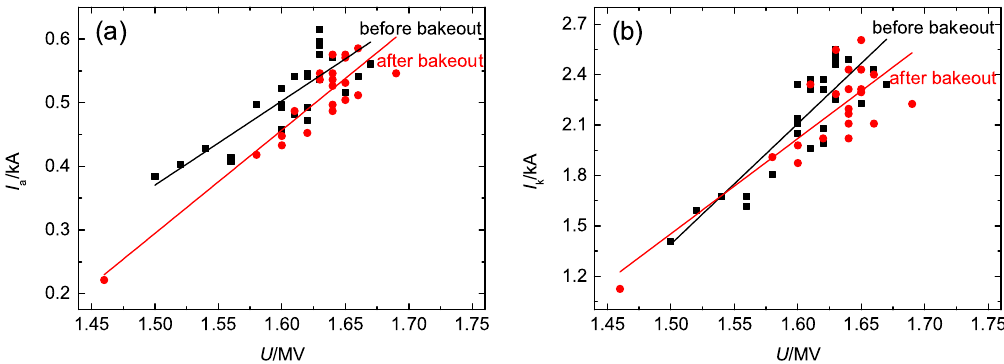
FIG. 7. Emission current before and after bakeout of the CNT cathode: (a) anode current, (b) cathode